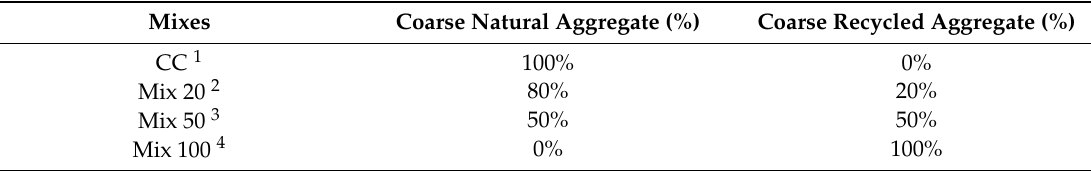
Table 5. Proportion of natural and recycled aggregates in the